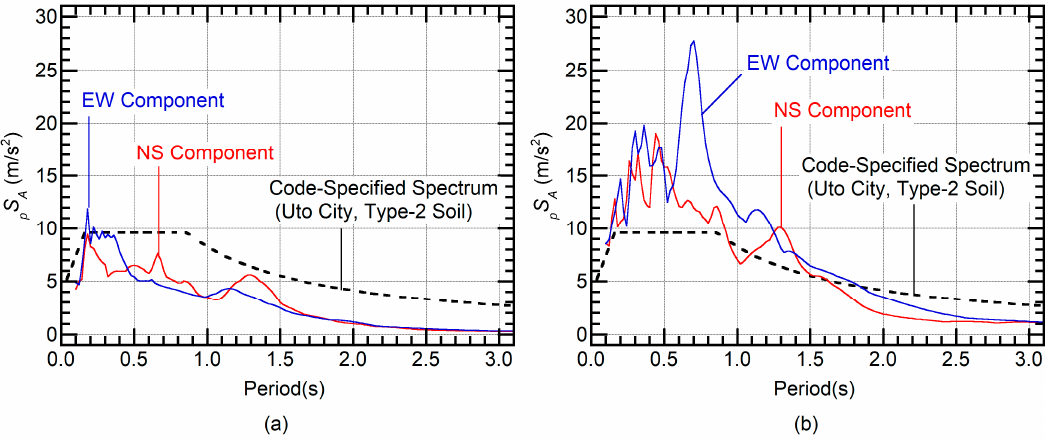
Figure A8. Pseudo acceleration response spectrum of two recorded ground motion at the K-NET Uto Figure A8 . Pseudo acceleration response spectrum of two recorded ground motion at the K-NET Uto Station: ( a ) 14 April earthquake, and ( b ) 16 April Station: ( a ) 14 April earthquake, and ( b ) 16 April earthquake. Figure A8 . Pseudo acceleration response spectrum of two recorded ground motion at the K-NET Uto Station: ( a ) 14 April earthquake, and ( b ) 16 April earthquake. Figure A8 . Pseudo acceleration response spectrum of two recorded ground motion at the K-NET Uto Station: ( a ) 14 April earthquake, and ( b ) 16 April earthquake.